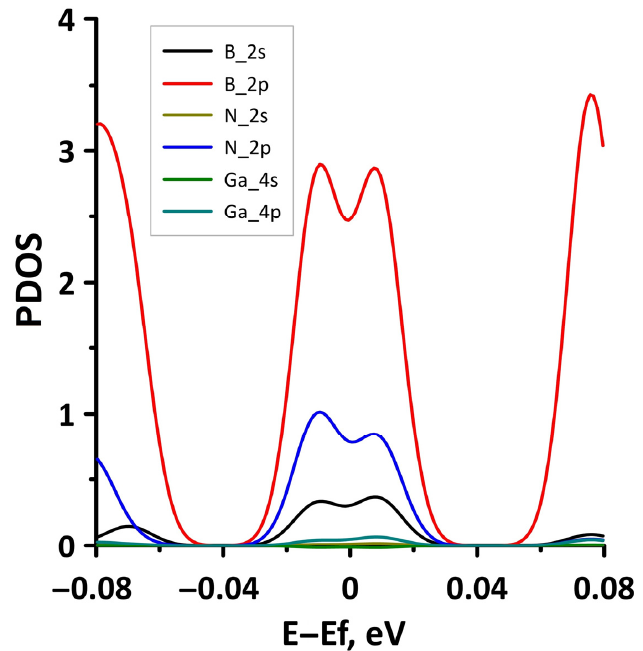
Figure 20. Fragments of PDOS near the Fermi level (shifted to 0 eV) of borophene/GaN heterostruc- ture under biaxial compression by 2%.